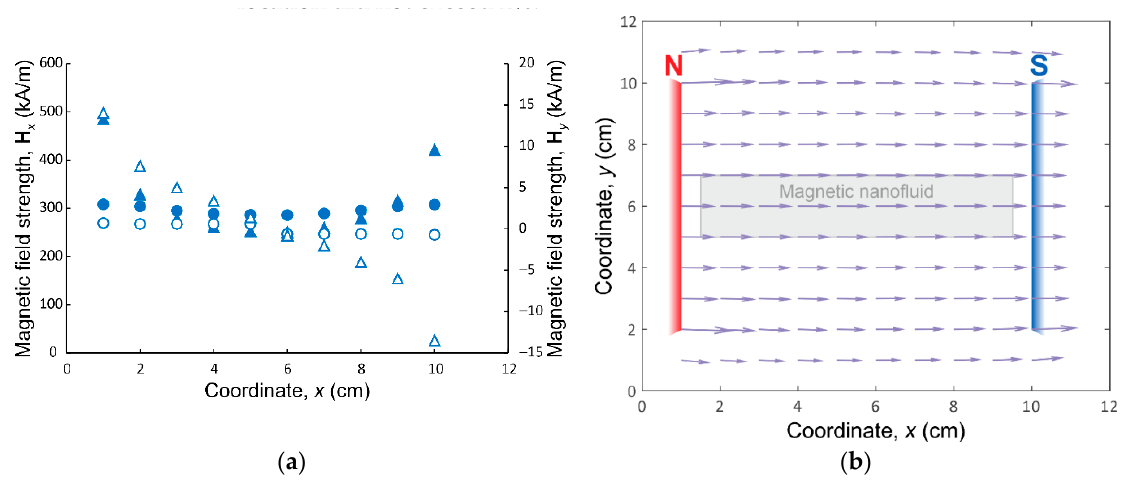
Figure 3. ( a ) The dependencies of the magnetic field strength components on the horizontal coordinate between the electromagnet poles. The circles correspond to the range of the vertical coordinate values in which the magnetic nanofluid layer is located. The triangles correspond to the values measured along the line connecting the edges of the poles. Filled symbols correspond to the x -component of the magnetic field strength, and open symbols correspond to the y -component. ( b ) Magnetic field strength vector field in the experimental setup.